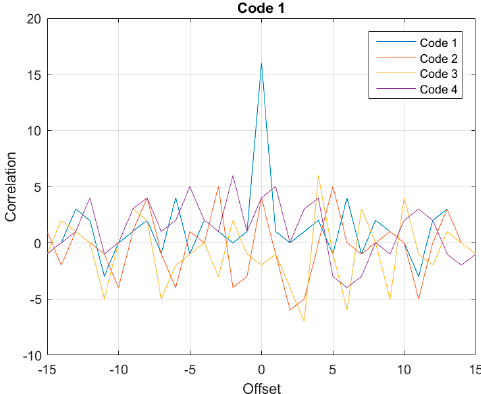
Figure 9. Correlation of four 16-bit Gold codes.